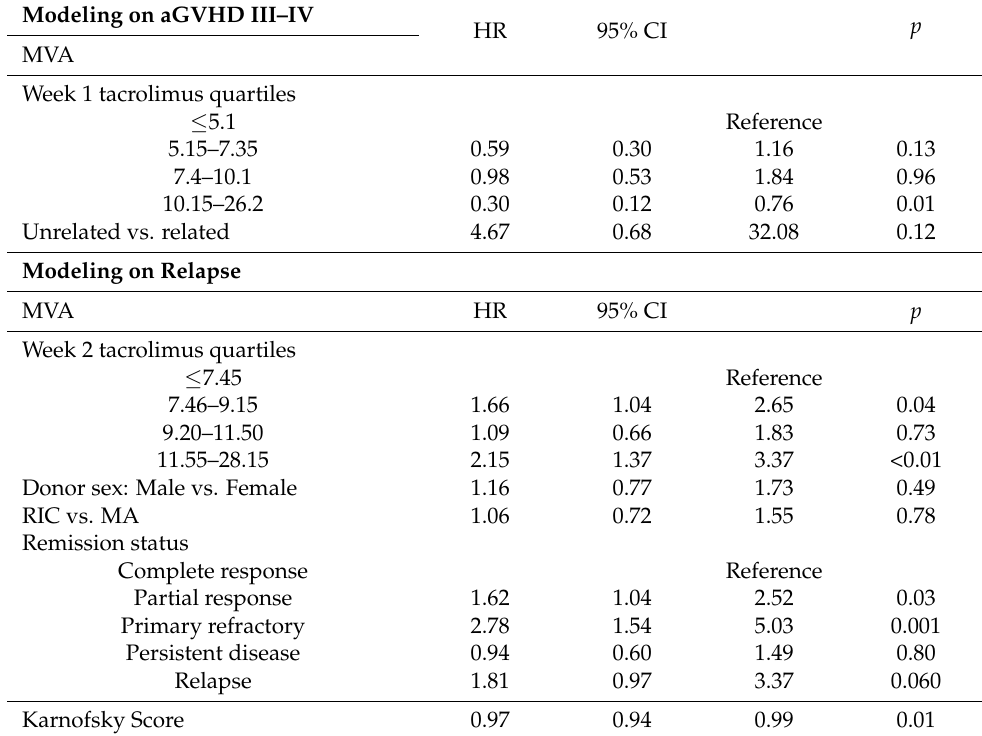
Table 5. Multivariable analysis for factors affecting the incidence of aGVHD and relapse in patients who received